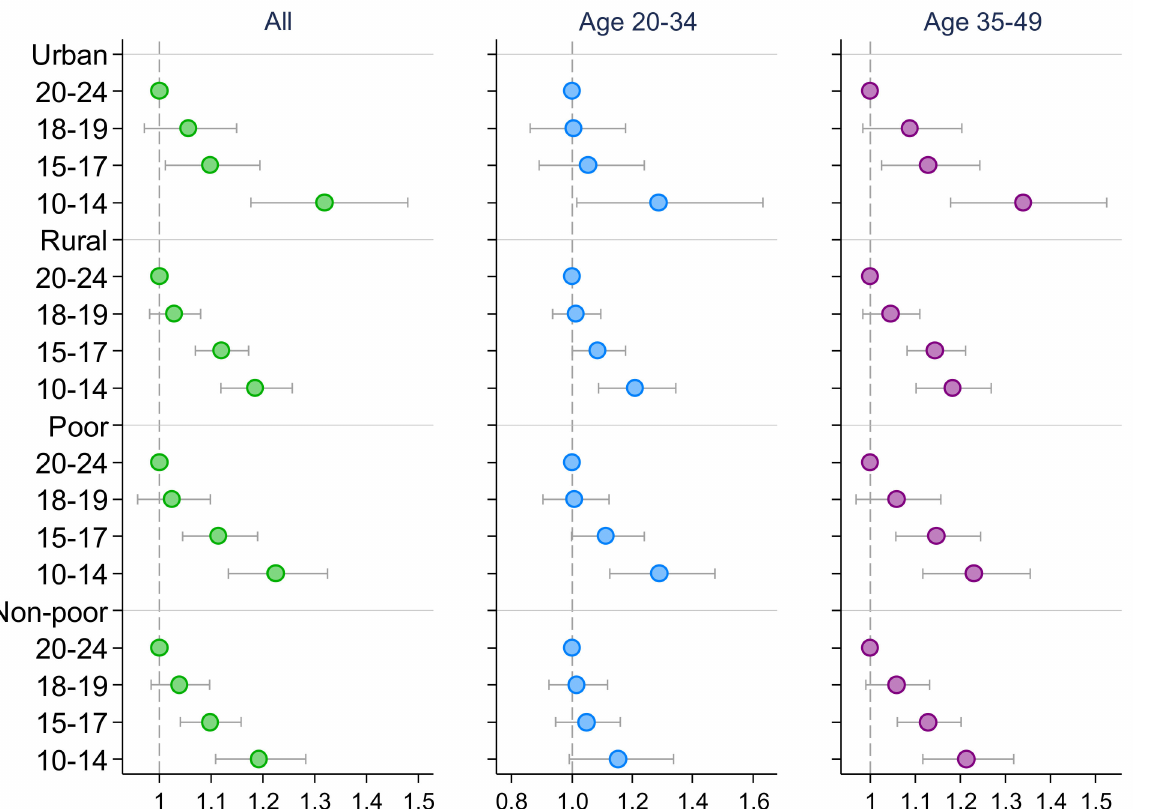
Figure 6. Adjusted odds ratios in favor of having high blood glucose by age at marriage by ur- ban/rural and poor/non-poor sub-samples. Estimates were obtained using complex survey weights. The horizontal lines across the markers represent 95% confidence intervals. All regressions included the following covariates: age, educational attainment, marital status, religion, caste, wealth index quintiles (for urban/rural sub-samples only), urban/rural residence (for poor/non-poor sub-samples only), body mass index (BMI) categories, parity (i.e., number of children born), tobacco use, alcohol consumption, pregnancy status, lactation status, and state fixed